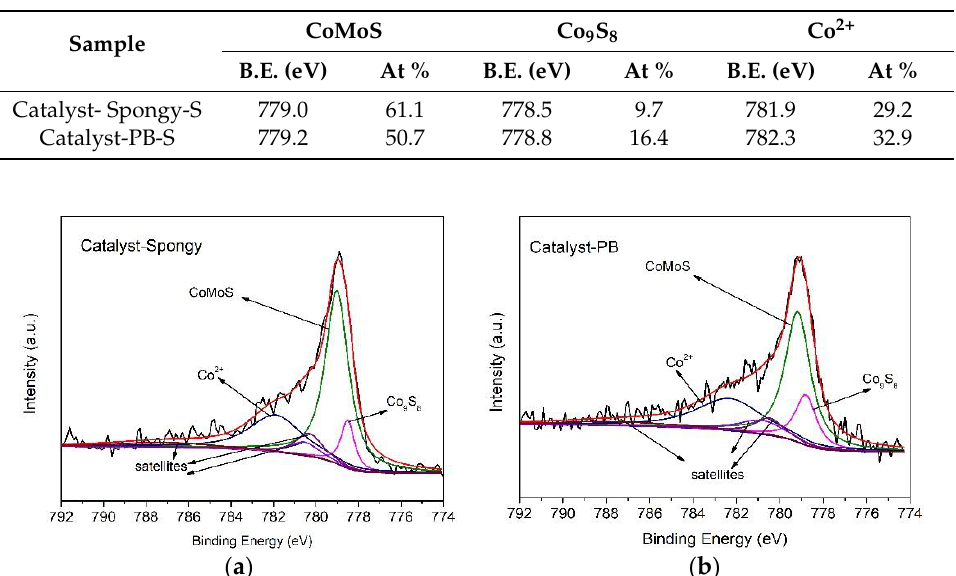
( c ) Figure 9. ( a ) The HDS network of DBT over hydrotreating catalysts. DBT (dibenzothiophene), BP (biphenyl), CHB (cyclohexylbenzene), BCH (bicyclohexyl), 4H-DBT (tetrahydrodibenzothiophene), 6H-DBT (hexahydrodibenzothiophene). Linear regression fit of −ln(1 − x) against time plots for ( b ) Catalyst- Spongy-S and ( c ) Catalyst-PB-S when the conversion of DBT is below 40%. By comparison, the results of conversion, initial HDS rate constants k HDS (expressed in mol Kg cat−1 s −1 , assuming pseudo-first-order kinetics) and the TOFs for different catalysts during the HDS of DBT are listed in Table 5. With regard to activity results, it is shown that Catalyst-Spongy-S